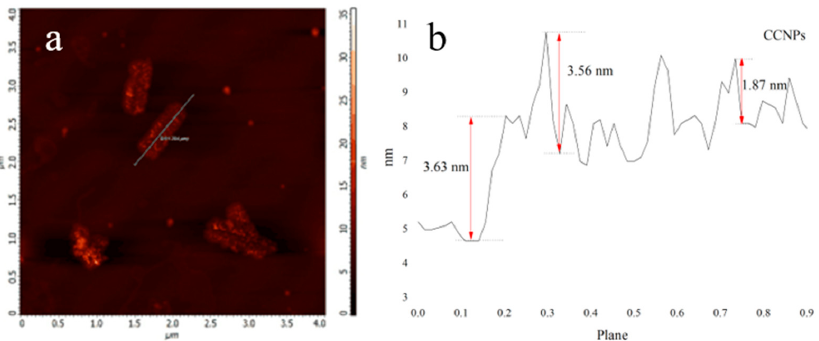
Figure 5. High magnification AFM diagram of CCNPs. ( a ) Morphology; ( b ) height.